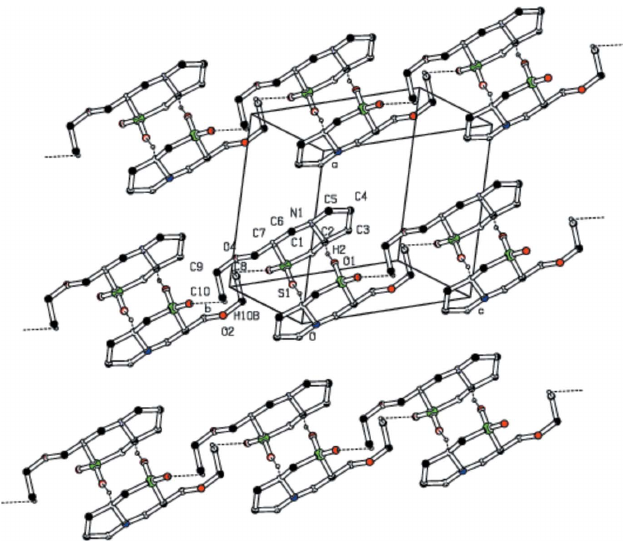
Figure 4 Packing of the title compound viewed along the c axis showing the C2— H2 (cid:3)(cid:3)(cid:3) O1 and C10—H10 B (cid:3)(cid:3)(cid:3) O2 hydrogen bonds forming R 2 R 2